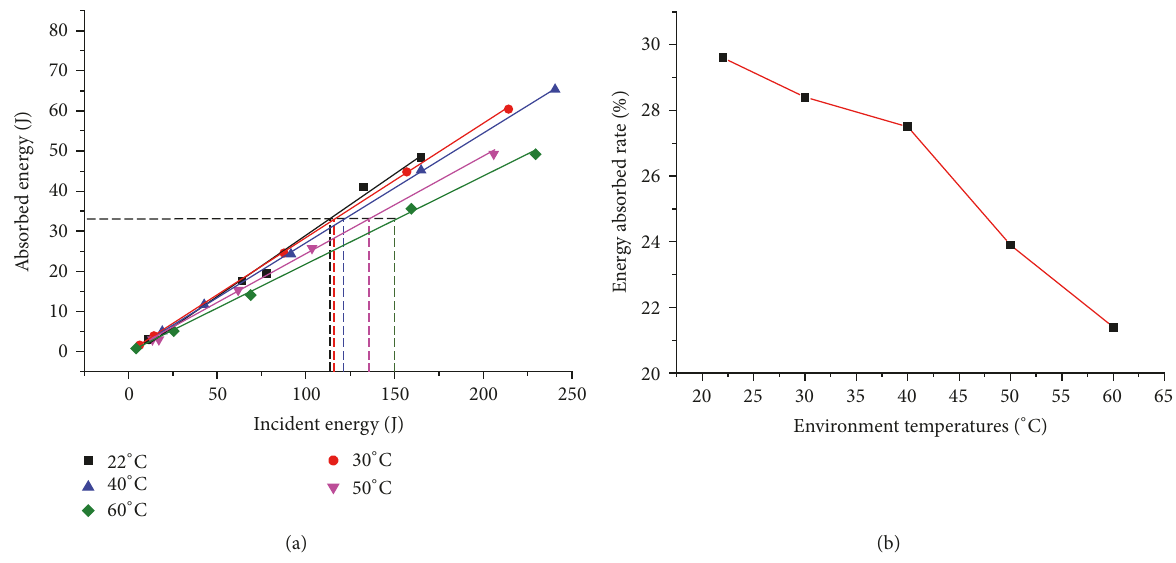
Figure 10: Energy-absorbing rates and their variation trend under different environmental temperatures.